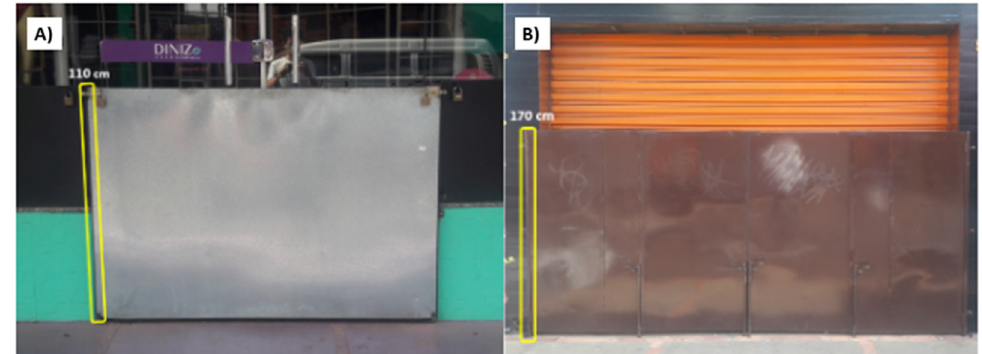
Figure 6. Example of floodgates installed. ( A ) A store located in Comendador Alfredo Maffei Avenue; ( B ) a store located in Geminiano Costa Street. These pictures were taken on 10 October 2020.